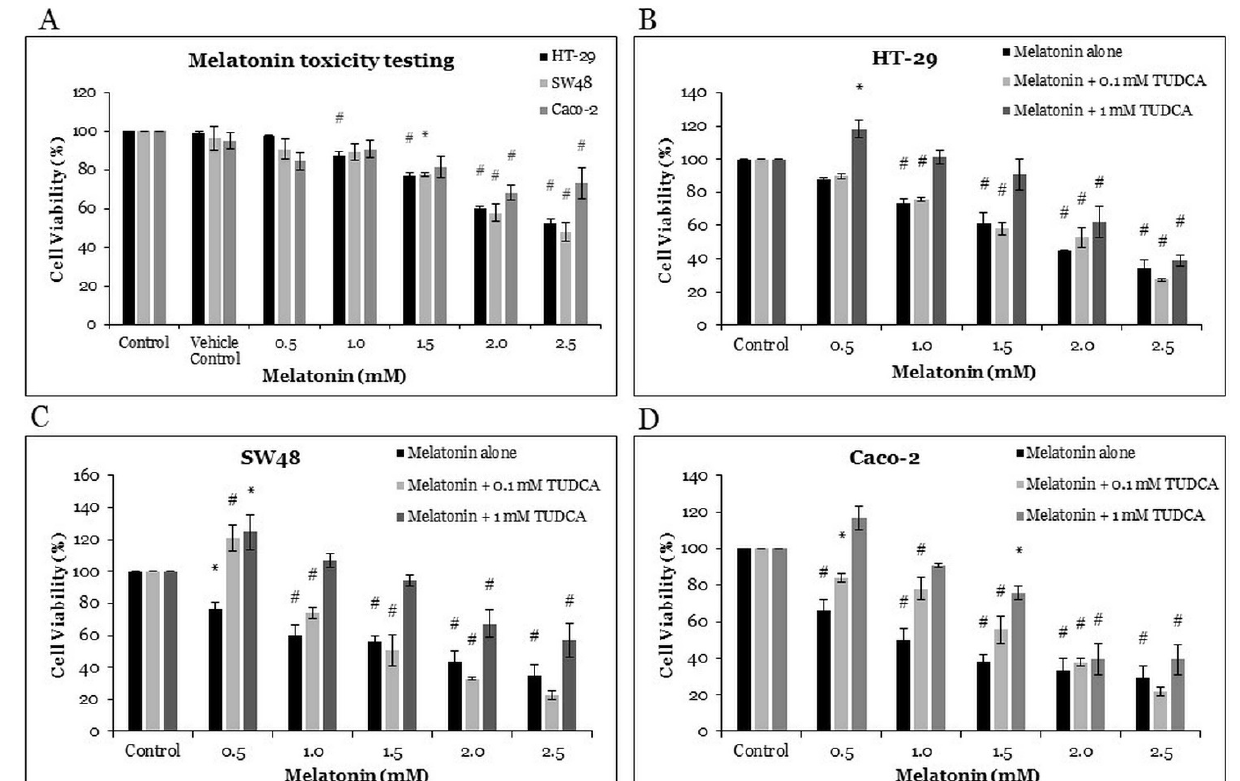
Figure 1. Cell viability assay: ( A ) HT-29, SW48, and Caco-2 were treated with various concentrations of melatonin for 72 h. ( B – D ) HT-29, SW48, and Caco-2 were treated with various concentrations of melatonin alone or together with 0.1 mM TUDCA or with 1 mM TUDCA. Means ± standard error of mean (SEM) of three separate experiments are shown. Two-way analysis of variance (ANOVA), followed by Dunnett’s post hoc test, was performed to compare each treatment group and control; statistically significantly different from control: *, p < 0.05; #, p < 0.01.